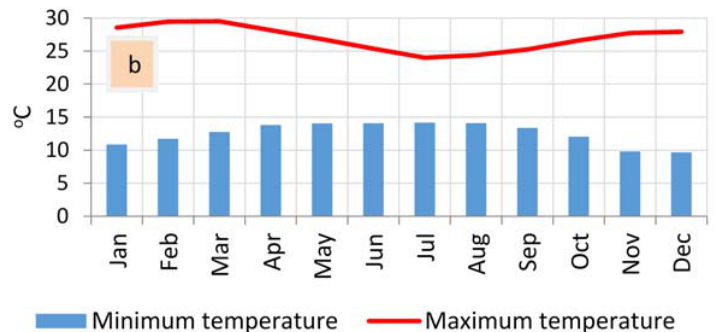
Figure 2. Distribution of monthly rainfall ( a ) and temperature ( b ) at Hawassa.